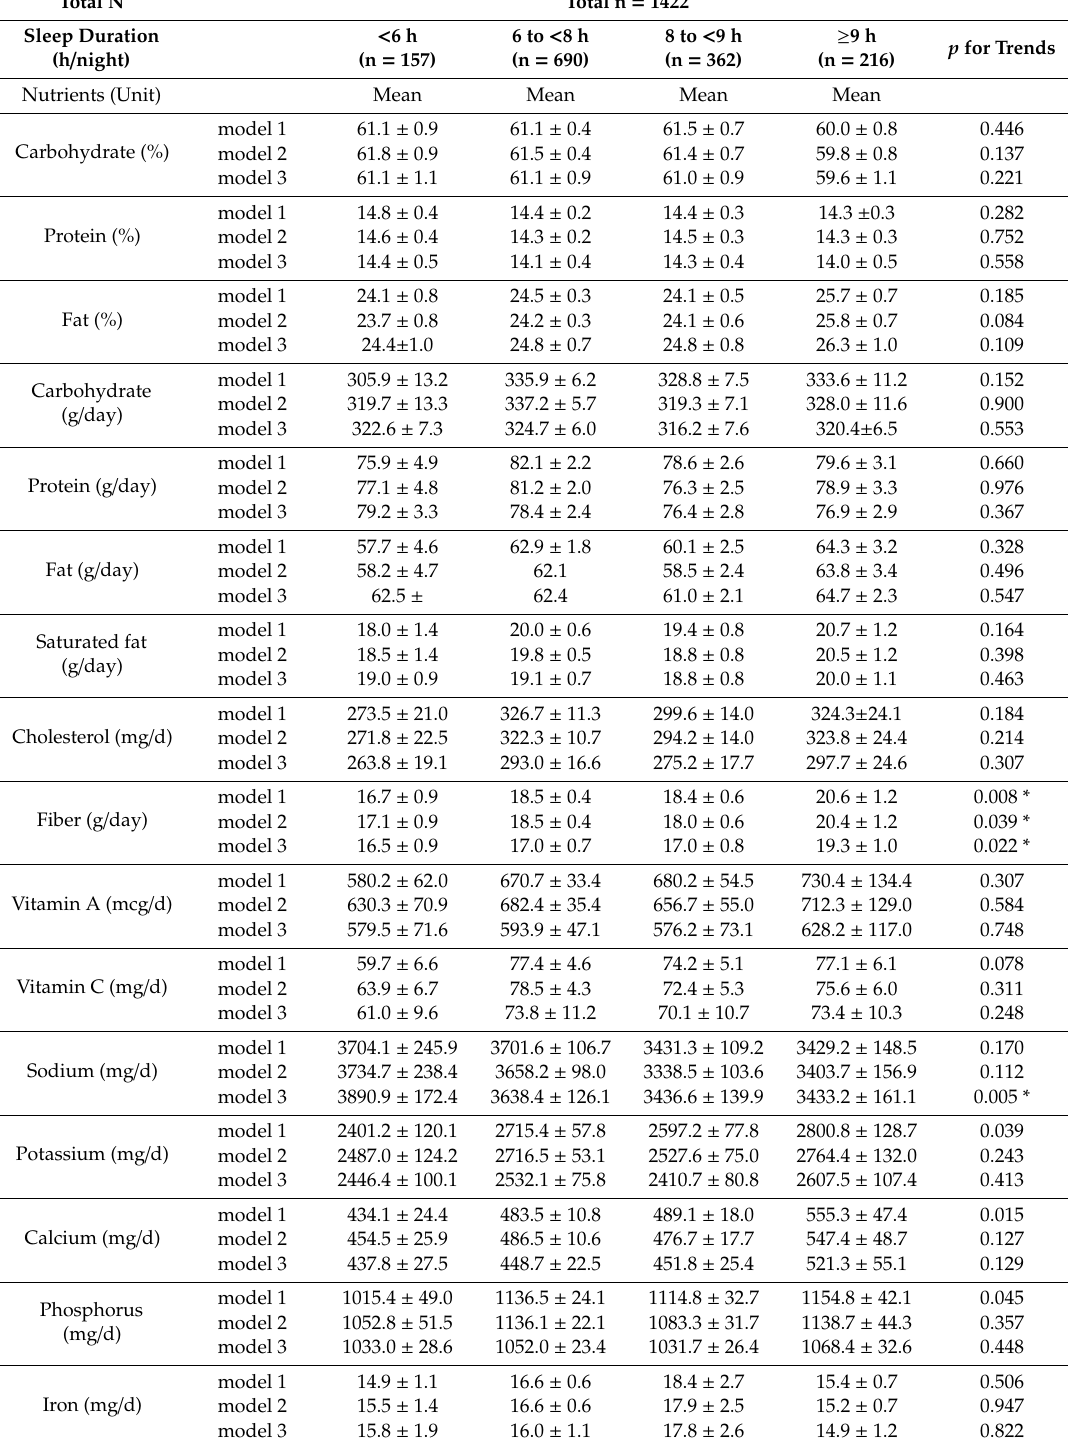
Table 3. Association between sleep duration and dietary nutrient